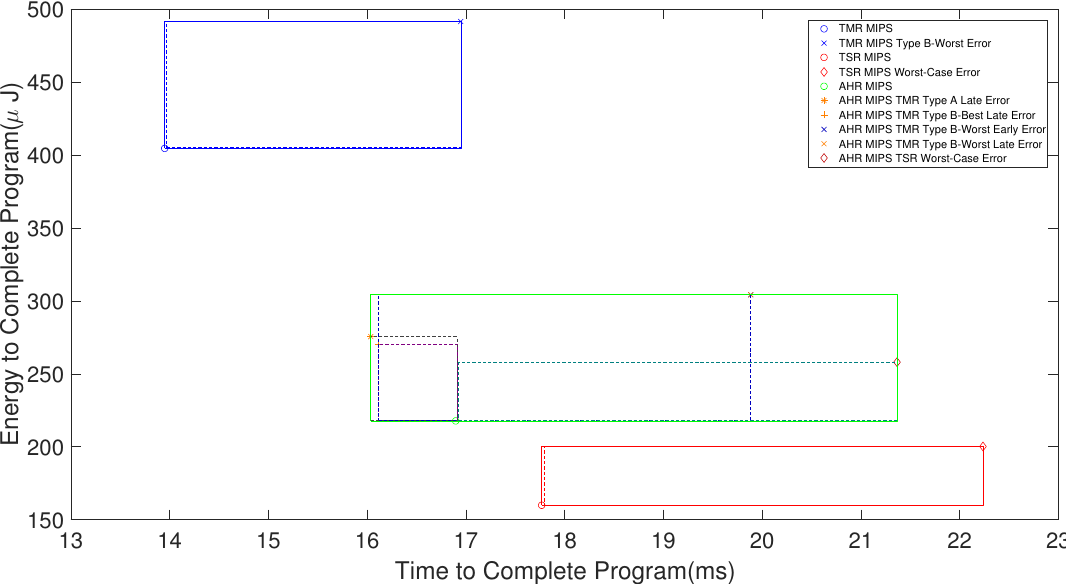
Figure 8. Average performance bounds for AHR MIPS with a TMR to TSR point at 11,000